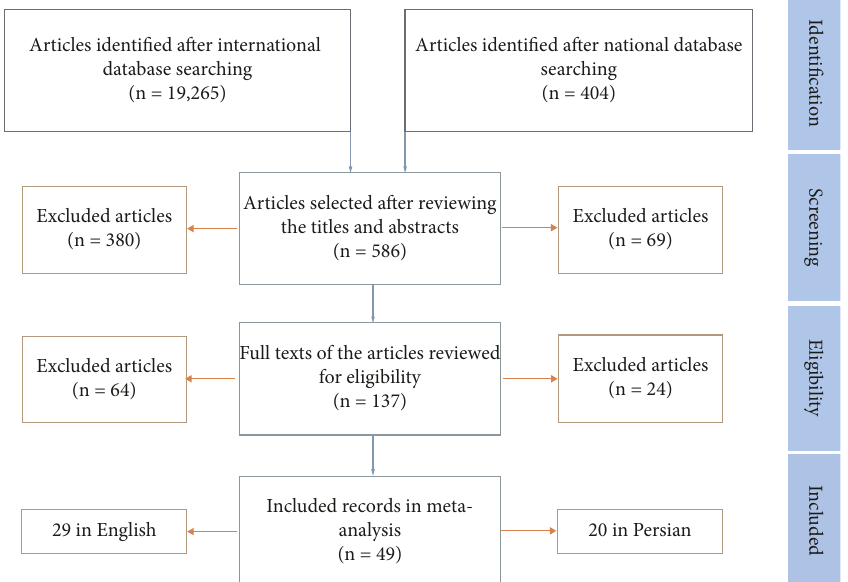
Figure 1: A schematic view of the study selection